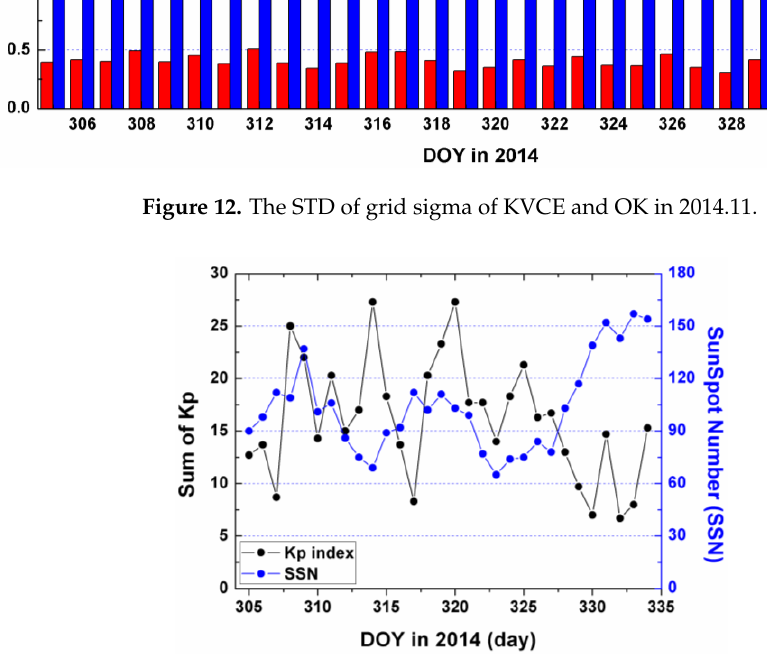
Figure 13. The Kp Index and Sunspot Number in 2014.11.